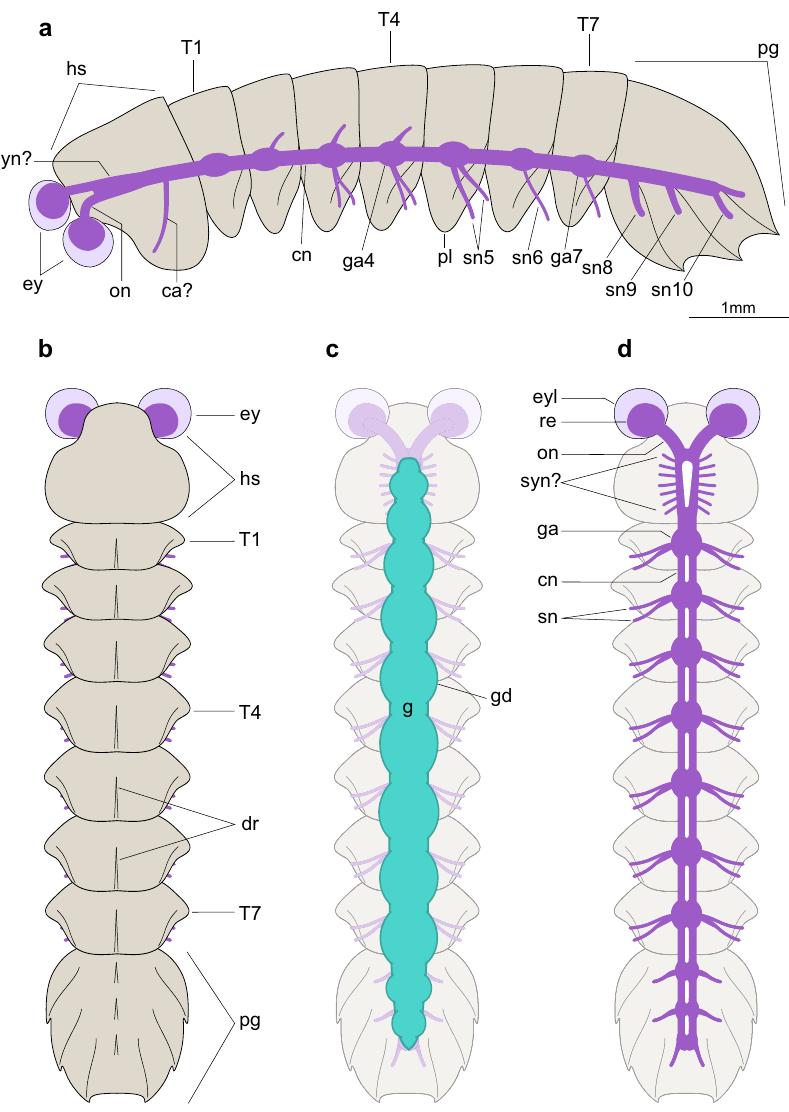
Fig. 4 Morphological interpretation and reconstruction of mollisoniid exoskeletal and internal anatomy. a USNM 305093, interpretative diagram. b Dorsal morphology of Mollisonia symmetrica ; appendicular data is omitted due to its incompleteness. c Internal anatomy showing the digestive system. d Central nervous system organization. The morphology and number of segmental nerves in the putative synganglion and esophageal foramen within the head shield are hypothetical, based on the appendicular data described for Mollisonia plenovenatrix from Burgess Shale and its suggested af fi nities with chelicerates 34 . ca? putative cephalic appendage, cn connective, dr dorsal ridge, ey lateral eye, eyl eye lens, g gut tract, ga n segmental ganglion, gd gut diverticulum, hs head shield, on optic nerve, pl pleura, pg pygidium, re retina, sn n n segmental nervesegmental nerve, syn? putative synganglion, sn n segmental nerve, T n trunk